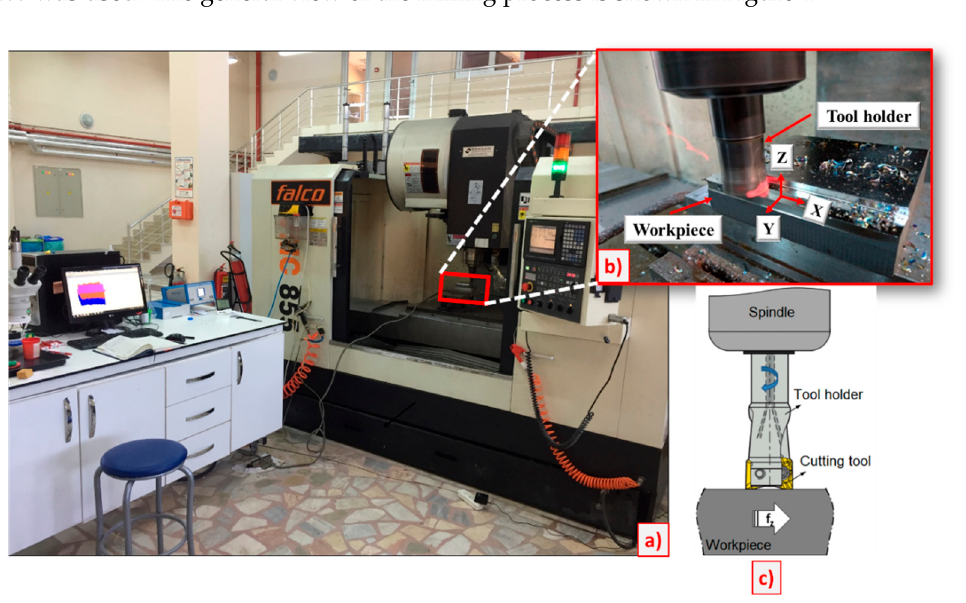
Figure 4. The symbolic representation of ( a ) the milling machine, ( b ) the experimental setup, and ( c ) the face milling process used in cutting tests.